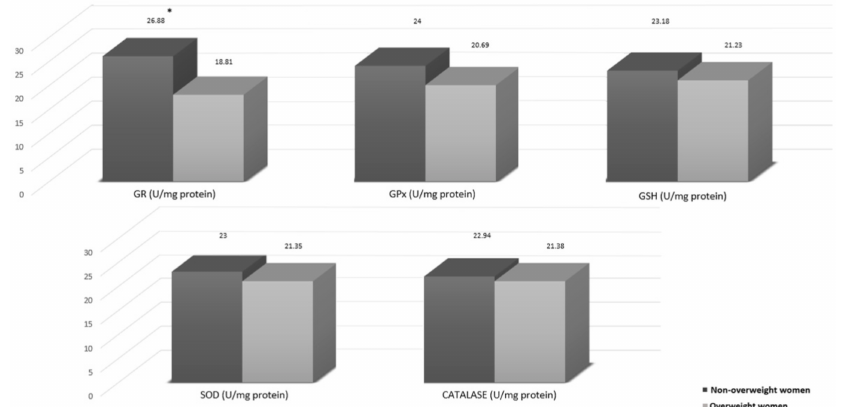
Figure 3. Association of overweight with plasma markers related redox status in T2 ( n = 43). GR, Glutathione Reductase; GPx, Glutathione Peroxidase; GSH, Reduced Glutathione; SOD, Superoxide Dismutase; CAT, Catalase. * Value of p = 0.039. Dark gray shows means for non-overweight women and light gray shows means for overweight women. Mann Whitney test.